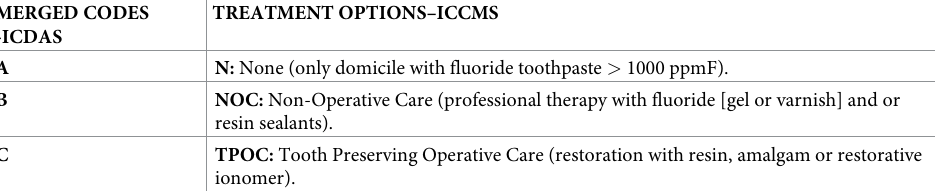
Table 2. Clinical caries treatment options based ICCMS TM and adapted for the epidemiological